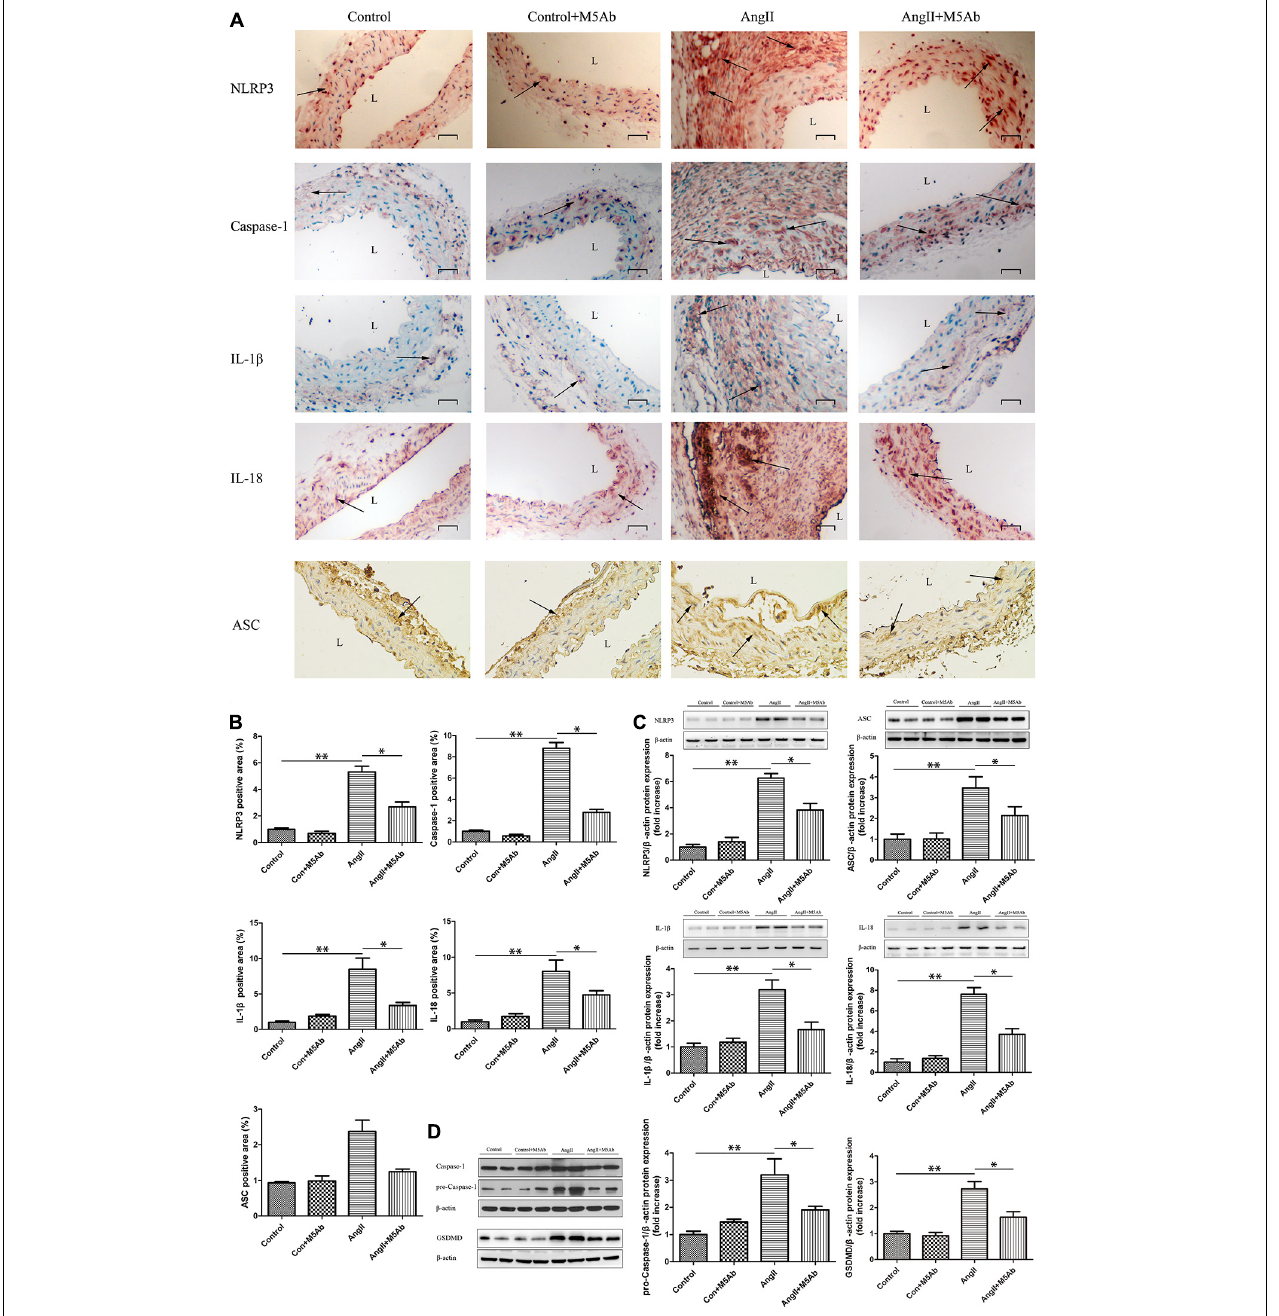
FIGURE 4 | M5Ab inhibits Ang II-induced expression of pyroptosis-related inflammatory factors in mice by blocking the expression of OPN-N. (A,B) Immunohistochemistry staining of NLRP3, Caspase-1, ASC, IL-1 β , and IL-18 in mice under different treatments, quantification of these pyroptosis-related inflammatory factors area (below). Scar bar 25 µ m. (C,D) Western blotting analyses of the protein levels of NLRP3, ASC, IL-1 β , IL-18, pro-Caspase-1, and GSDMD in mice, and quantification of these pyroptosis-related inflammatory proteins expression. β -actin was used as an internal control. Data are expressed as means ± SEM; n = 3 per group. ∗ P < 0.05 vs the Ang II + M5Ab group; ∗∗ P < 0.05 vs the control and control + M5Ab groups. Abbreviations: Ang II, angiotensin II; IL, interleukin; NLRP3, NOD-, LRR-, and pyrin domain-containing protein 3; and L, lumen.